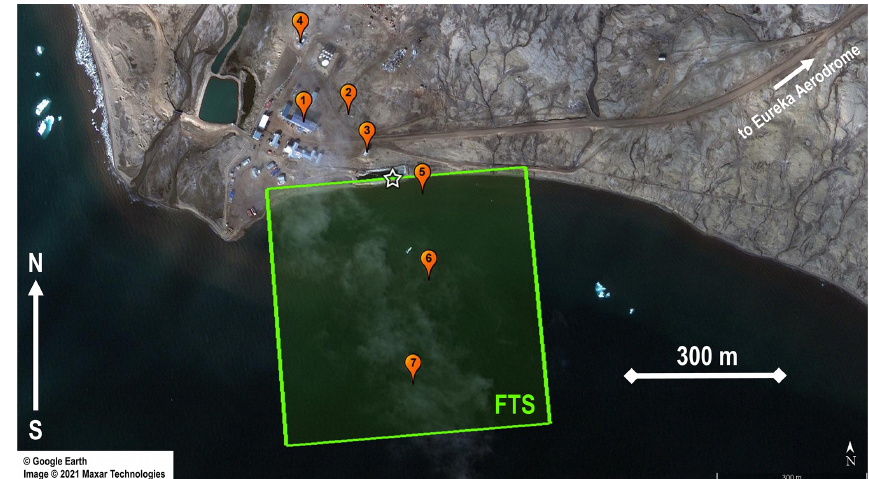
Figure 3. The Fjord Test Site (FTS) – a flight region on Slidre Fjord near the Eureka weather station. Pins in the figure indicate the locations of the ECCC WS main building – no. 1, Eureka C weather observing site – no. 2, hydrogen shed (RS launch site) – no. 3 , 0PAL – no. 4, and temperature profiles measured by M210 RTK in the fjord on 10 March 2020 – nos. 5–7 (see further details in the text). The drone take-off and landing pad is marked by a star